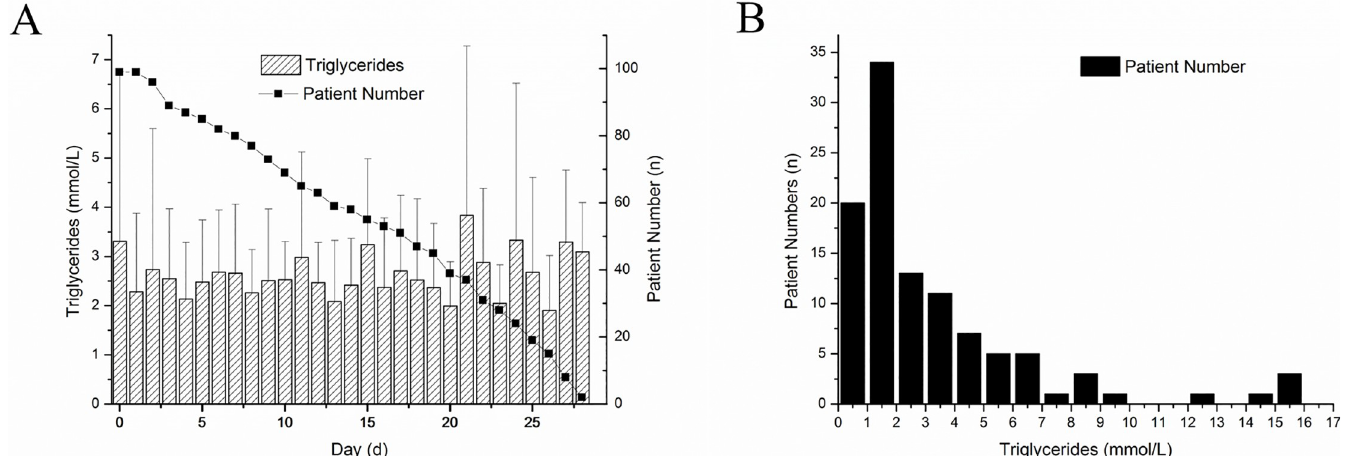
Fig 2. A: Changing trend of TG level from Day 0 to Day 28. Bar chart representing average TG level and patient numbers after admission. Day 0 stands for the admission. B: Distribution of TG level at admission for all enrolled patients. Forty SAP patients were admitted with an elevated TG level.